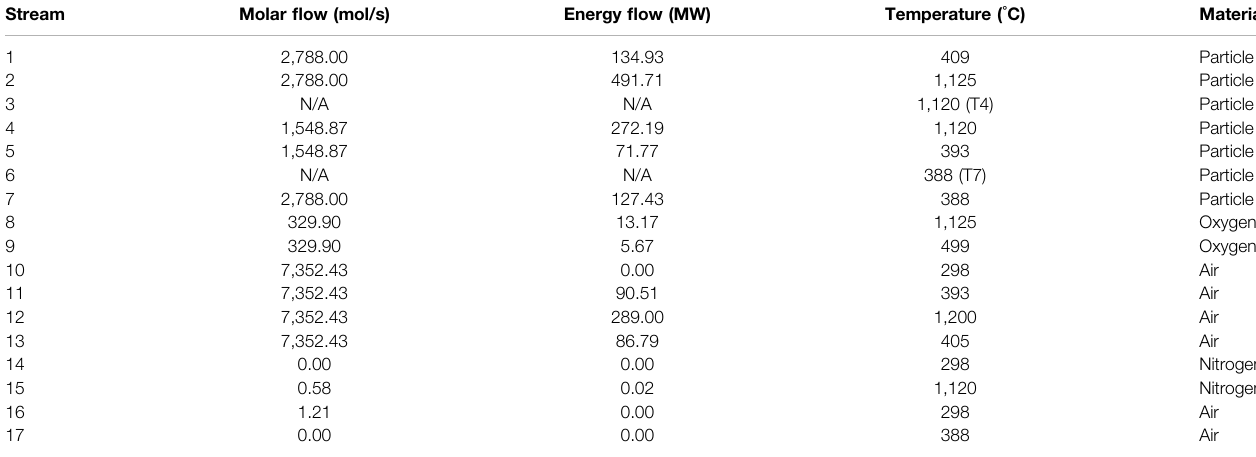
TABLE 6 | Mass and energy fl ows, and temperatures at the design state for fl uid streams (see Figure 1B for stream numbers). Stream Molar fl ow (mol/s) Energy fl ow (MW) Temperature ( ° C) Material